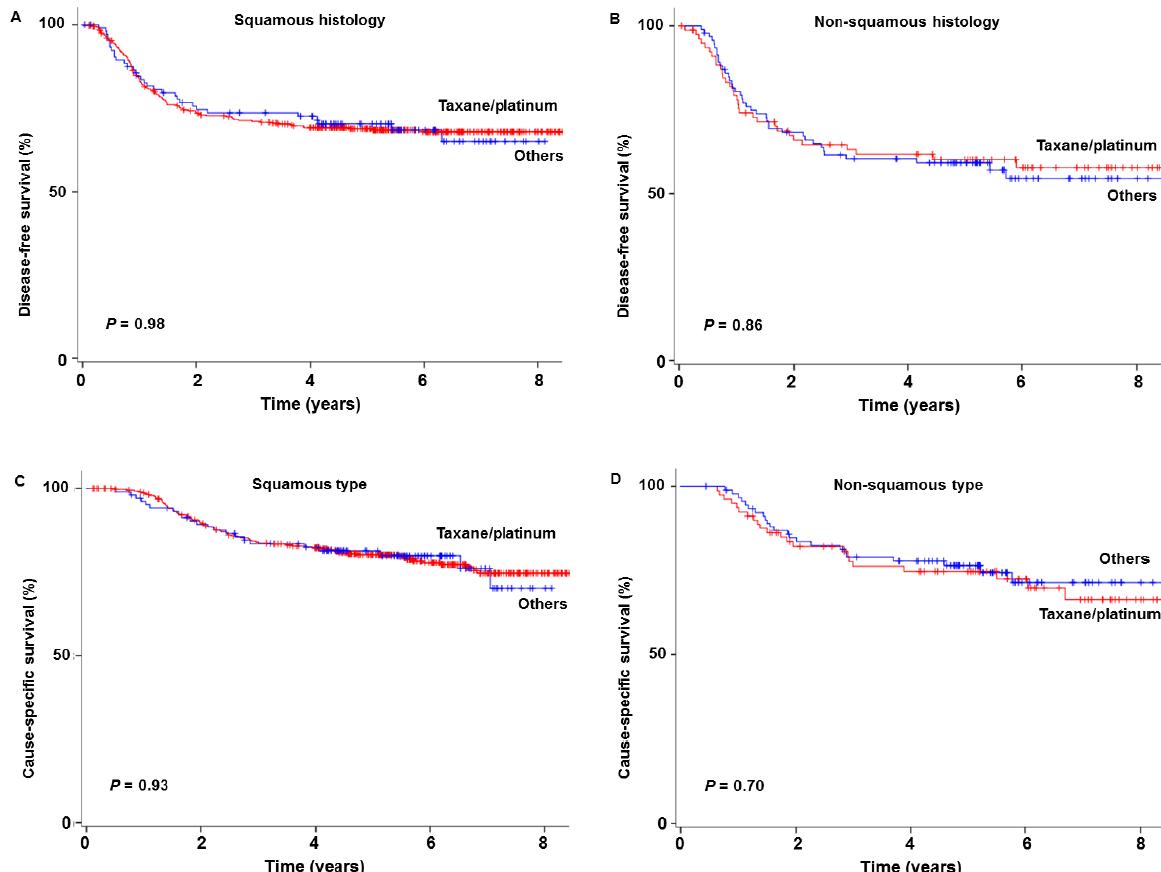
Figure 1. Survival outcomes based on histology types. Log-rank test for P -values. Survival curves are shown for disease-free ( A ) and cause-specific ( C ) in squamous type and disease-free ( B ) and cause-specific ( D ) in non-squamous type.